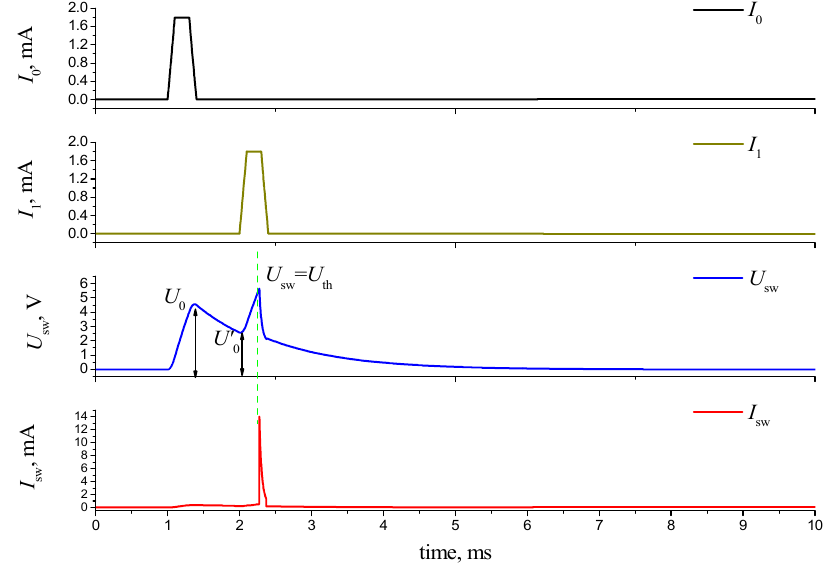
Figure 15. Oscillograms of the voltage U sw and the current I s response at the switch when exposed to two successive current pulses from sources I 0 and I 1 . The circuit uses a VO 2 switch (Figure 2a).